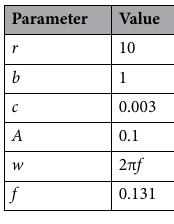
Table 1. Values of the parameters used in the numerical